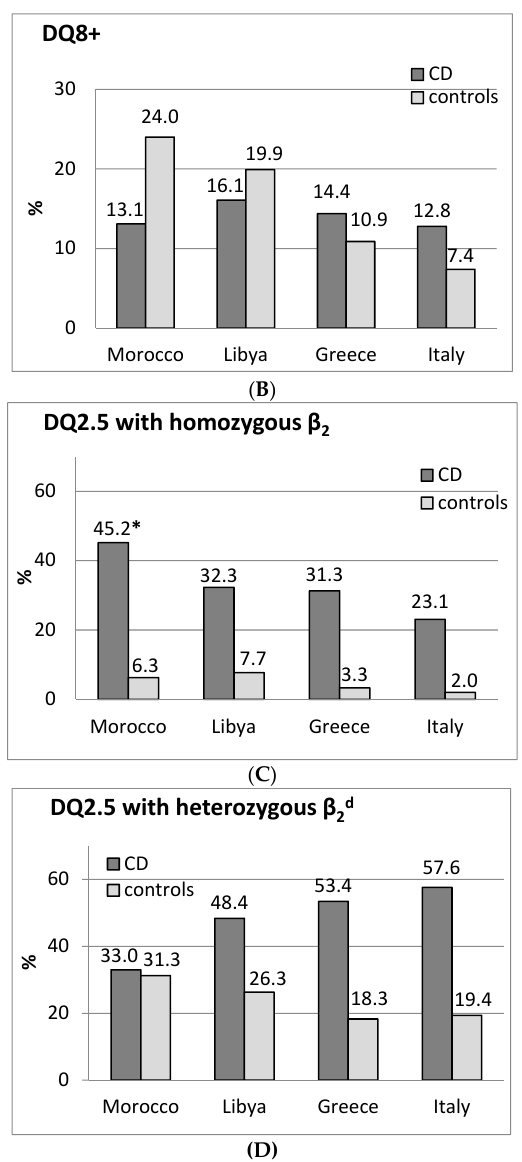
Figure 1. Distribution of HLA-DR-DQ genotypes in celiac disease (CD) and controls from Morocco a , from North Africa b and from other Mediterranean populations c . Genotype frequencies (%) are reported on the top of the columns. ( A ) frequencies of DQ2.5 positive/DQ8 negative individuals; ( B ) frequencies of DQ8 positive individuals; ( C ) frequencies of DQ2.5 with homozygous β 2 chain individuals (DQ2.5 homozygous); ( D ) frequencies of DQ2.5 with heterozygous β 2 chain individuals. * p < 0.001 vs. controls. d Figure 1D includes DQ8+ individuals (DQ2.5/DQ8 genotypes). Population